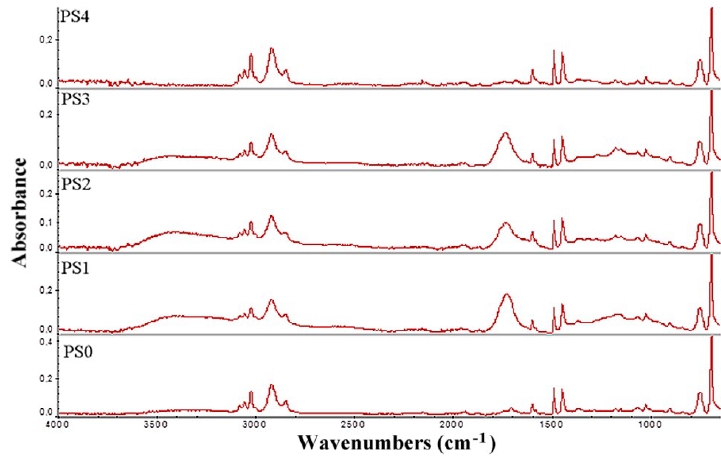
Figure 3. FTIR results of PS0–4 samples.